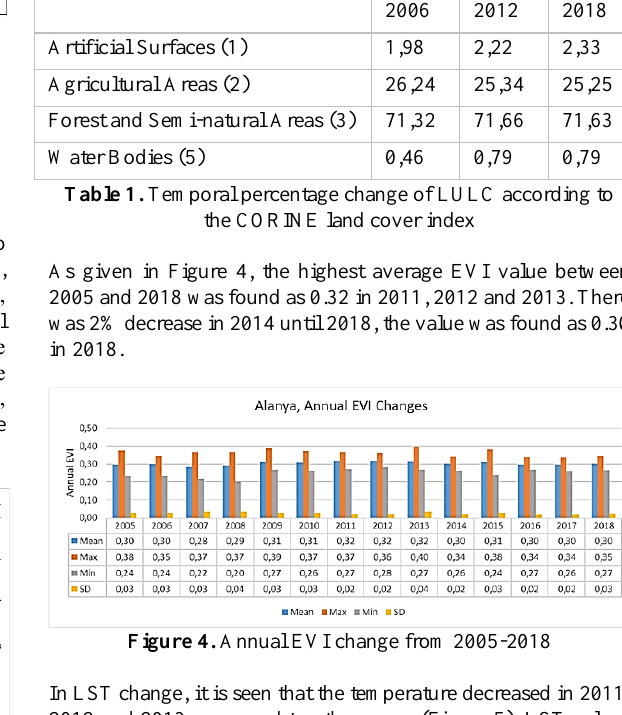
Figure 2. Average monthly air temperature and monthly